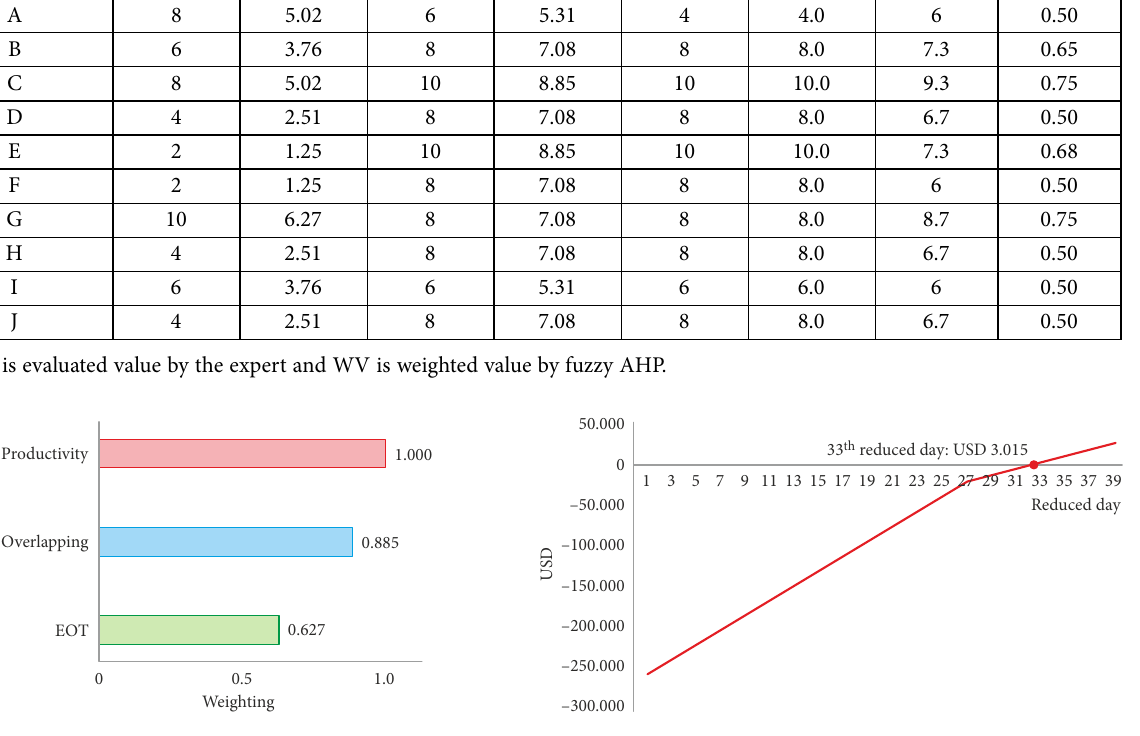
Figure 4. The importance of the selection factors by fuzzy AHP Figure 5. The economic analysis of the proposed method